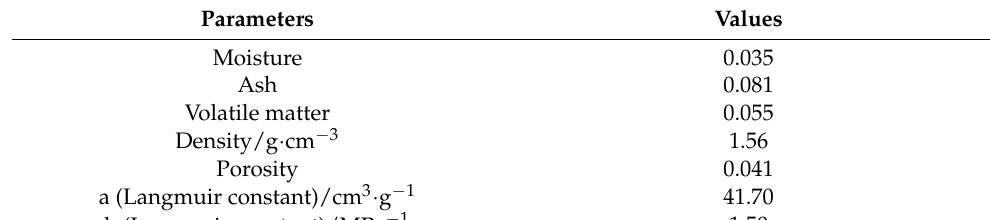
Table 1. Basic parameters of the Guhanshan coal. Parameters